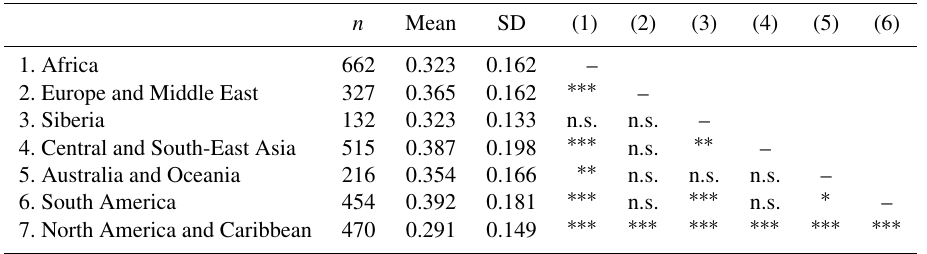
Table A4. Summary statistics and pairwise comparisons of how MAI-500 (the model agreement index of GFPLAIN, GAR-500, and JRC- 500) varies with different geographic regions. A Kruskal–Wallis test showed that there is a significant difference in model agreement between the regions ( H( 6 ) = 146, p < 0 . 001). The pairwise comparisons, for detecting significant differences between the regions, have been con- ducted using the Wilcoxon rank-sum test with continuity